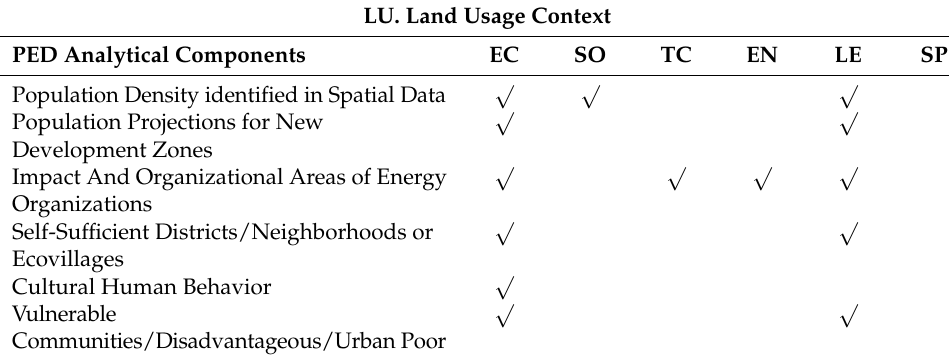
Table 12. Criteria considered for Social PED analytical components analysis. LU. Land Usage